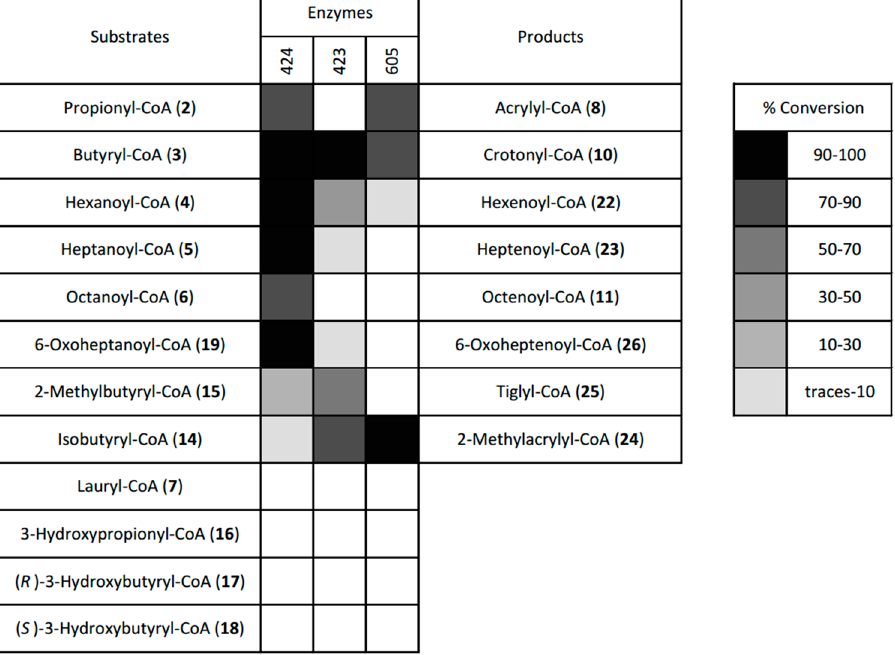
Figure 2. Substrate promiscuity of the three acyl-CoA dehydrogenases characterized in this study. The following enzymes were cloned from Rhodobacter sphaeroides and produced heterologously in Escherichia coli : medium-chain acyl-CoA dehydrogenase, 424; putative short-chain acyl-CoA dehydrogenase, 423; putative branched-chain acyl-CoA dehydrogenase, 605. Conversion rates were measured by HPLC-UV at 260 nm as described in material and methods.